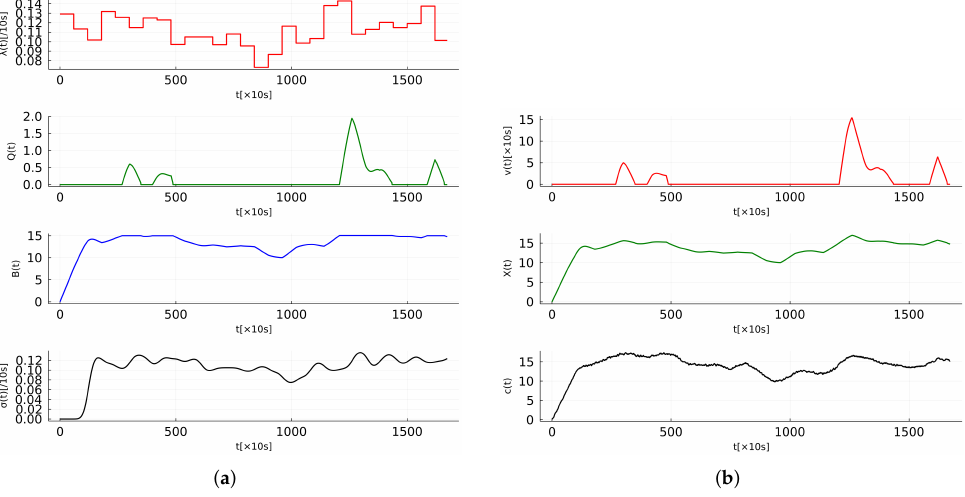
Figure 6. Results of current terminal airspace with s av ( t ) = 15.0, c av ( t ) , g av ( x ) , and f av ( x ) . ( a ) λ av ( t ) [/10 s], Q av ( t ) , B av ( t ) , and σ av ( t ) [/10 s] from top to bottom. ( b ) v av ( t ) [×10 s], X av ( t ) = B av ( t ) + Q av ( t ) , and c av ( t ) from top to